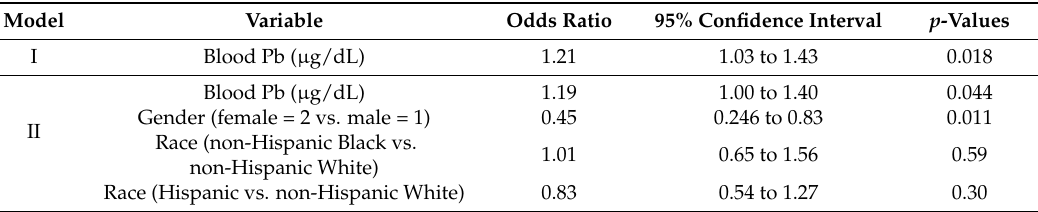
Table 2. A summary of survey logistic regression models 1 generated in this study to examine the potential relationship between blood Pb levels and the risk of learning disabilities.